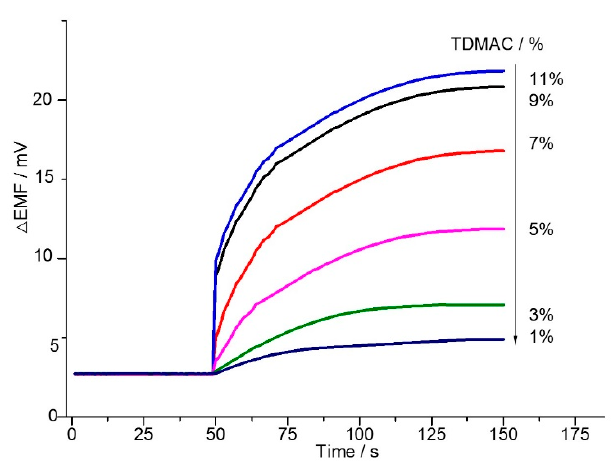
Figure 2. The effect of the amount of TDMAC on the potentiometric response of permanganate ions based membrane electrode (the concentration of gallic acid was fixed at 1.7 g/L).